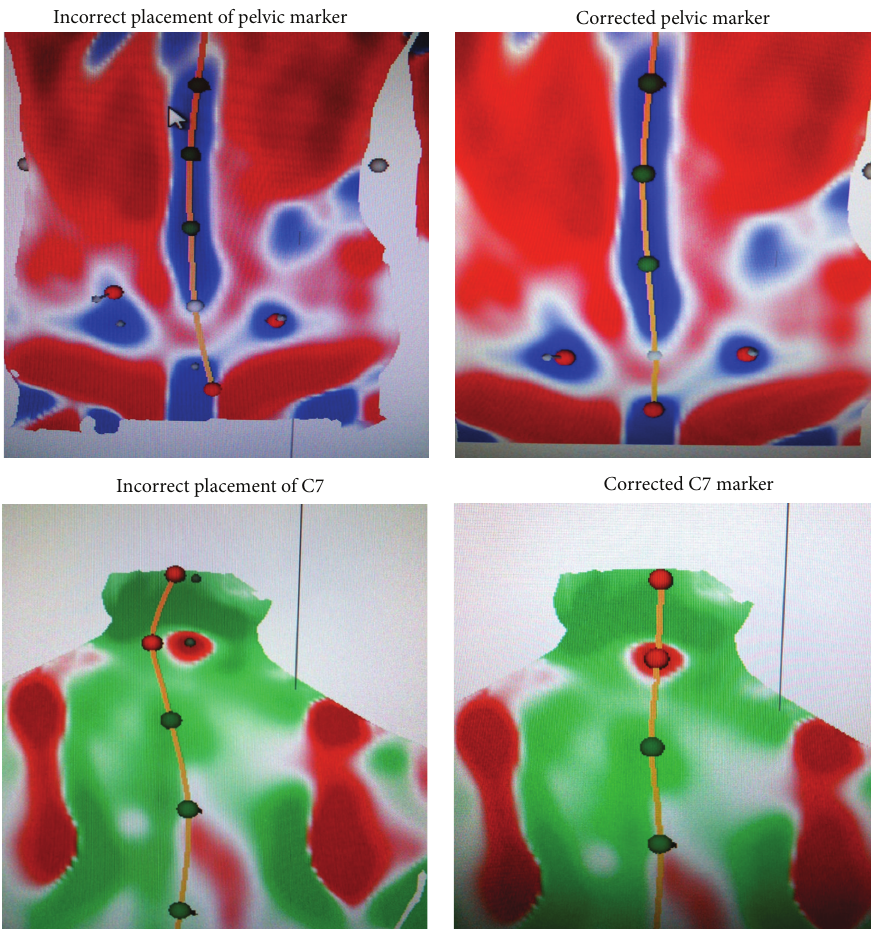
Figure 2: Adjustment of